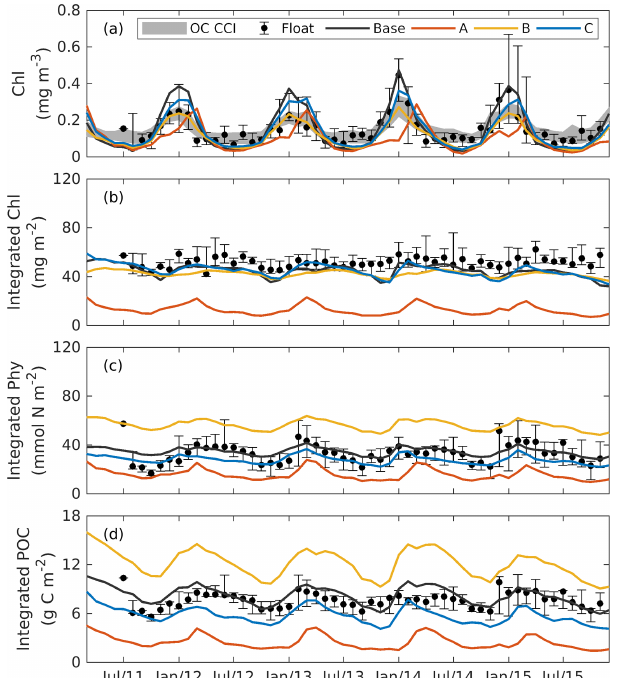
Figure 8. Observed and simulated seasonal cycles of surface chlorophyll (a) , vertically integrated chlorophyll (b) , vertically in- tegrated phytoplankton (c) , and vertically integrated POC (d) from each 3D model. Solid lines represent the median values over the deep ocean of GOM (depth > 1000m). Error bars and shades show the 25% and 75% percentiles. Chlorophyll, phytoplankton, and POC are integrated over the top 200m.